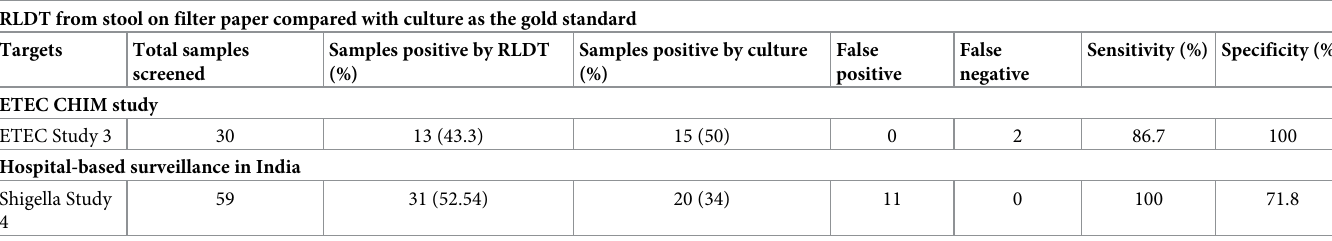
Table 5. Sensitivity and specificity of ETEC and Shigella RLDT from the stool on filter paper compared to culture. RLDT from stool on filter paper compared with culture as the gold standard